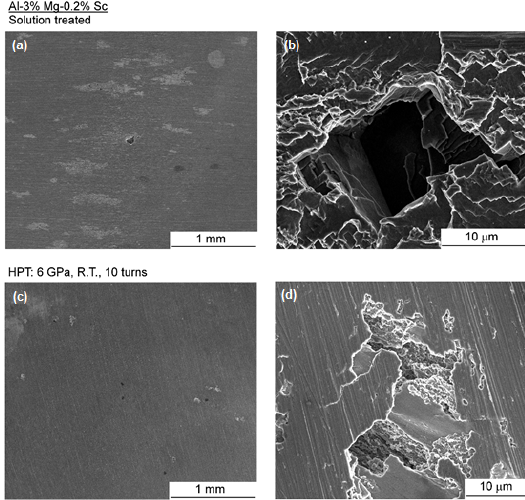
Figure 4. SEM micrographs of the surface of the (a, b) solution treated and the (c,d) HPT-processed alloy, at (a,c) low and (b,